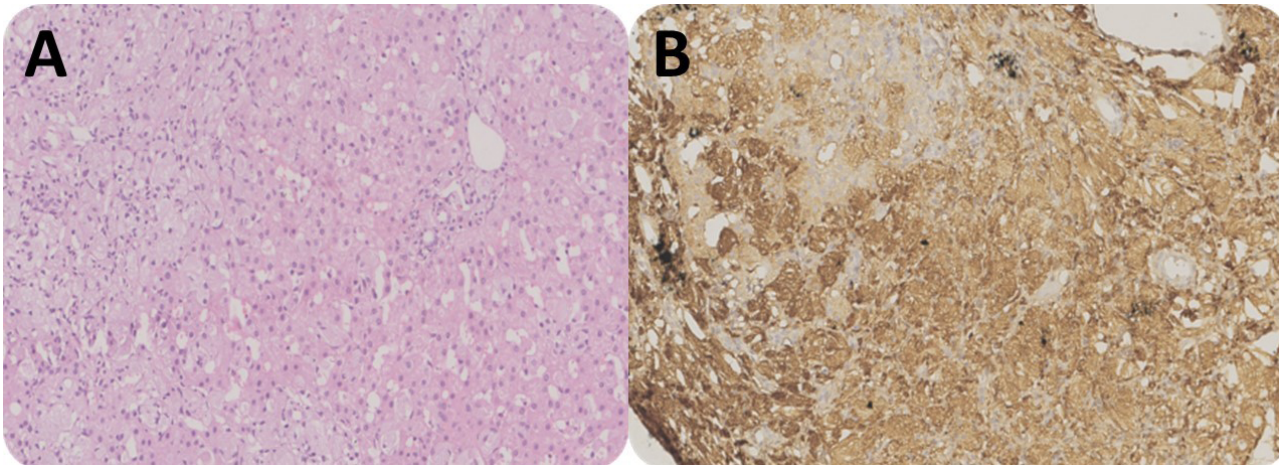
Figure 2. Histopathological appearance of liver involvement in GD. A : Gaucher cells infiltrating the liver parenchyma (200X, H&E stain). B : “Gaucher cells” strongly positive for CD68 on immunostaining (200X).